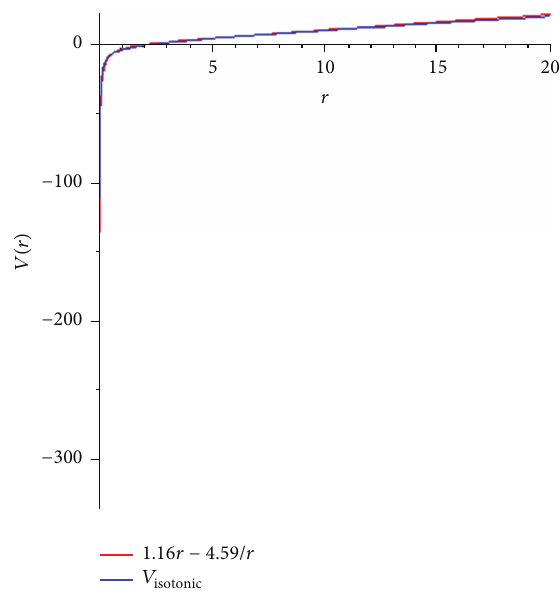
Figure 1: The red color shows the Cornell potential and the blue color shows the Killingbeck plus isotonic oscillator potential for 𝑎 = 0.0072 , 𝑏 = 1.16 , 𝑐 = −4.59 , 𝑑 = 0.0032 , ℎ = −2.7904 , and 𝑘 = 1.01008